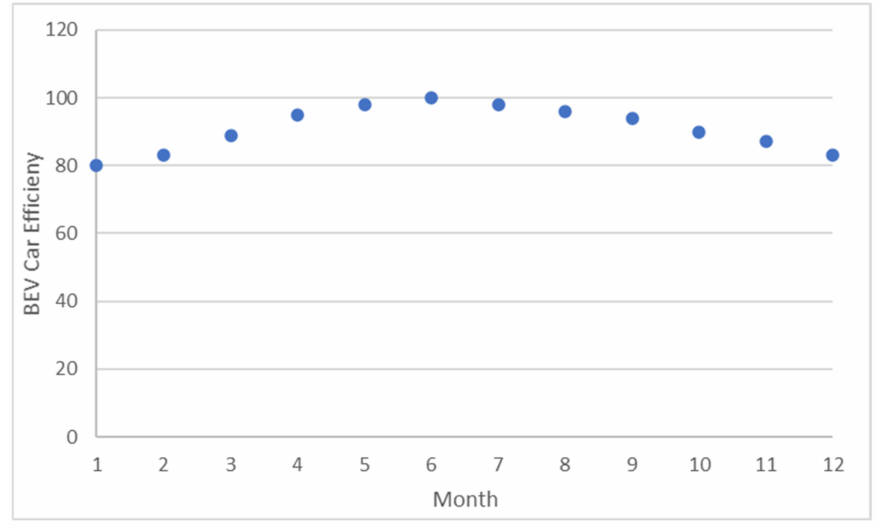
Figure 11. BEV car efficiency (kilometer per kWh) over the course of a year based on Austrian climate.